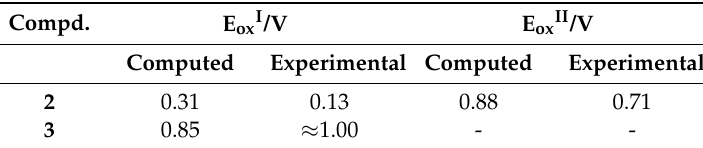
Table 4. Computed oxidation potentials for 2 and 3 in dichloromethane solvent, employing M06 exchange–correlation functional Compd. E oxI /V E oxII /V Computed Experimental Computed